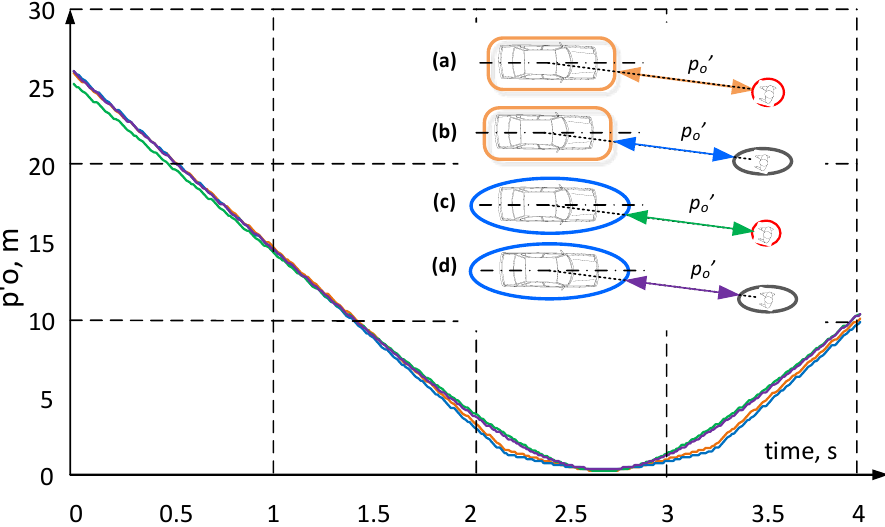
Figure 7. Change of p’o values, depending on the shape of the safety zone around the vehicle and the obstacle: ( a ) vehicle—rectangle, obstacle—circle; ( b ) vehicle—rectangle, obstacle—ellipse; ( c ) vehicle—ellipse, obstacle—circle; ( d ) vehicle—ellipse, obstacle—ellipse. Figure 8 shows the results of simulations which show how the distance between the safety zones of the vehicle change in the y -axis direction for different zone shapes and different speeds of the lateral movement of the obstacle.